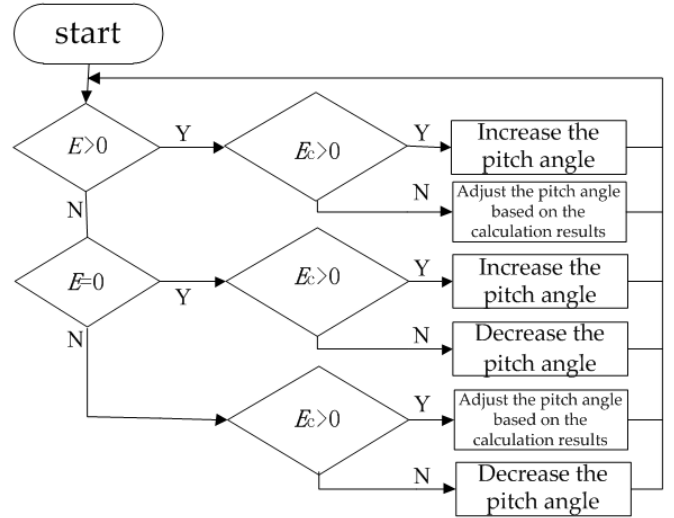
Figure 4. Flow chart of the control logic.